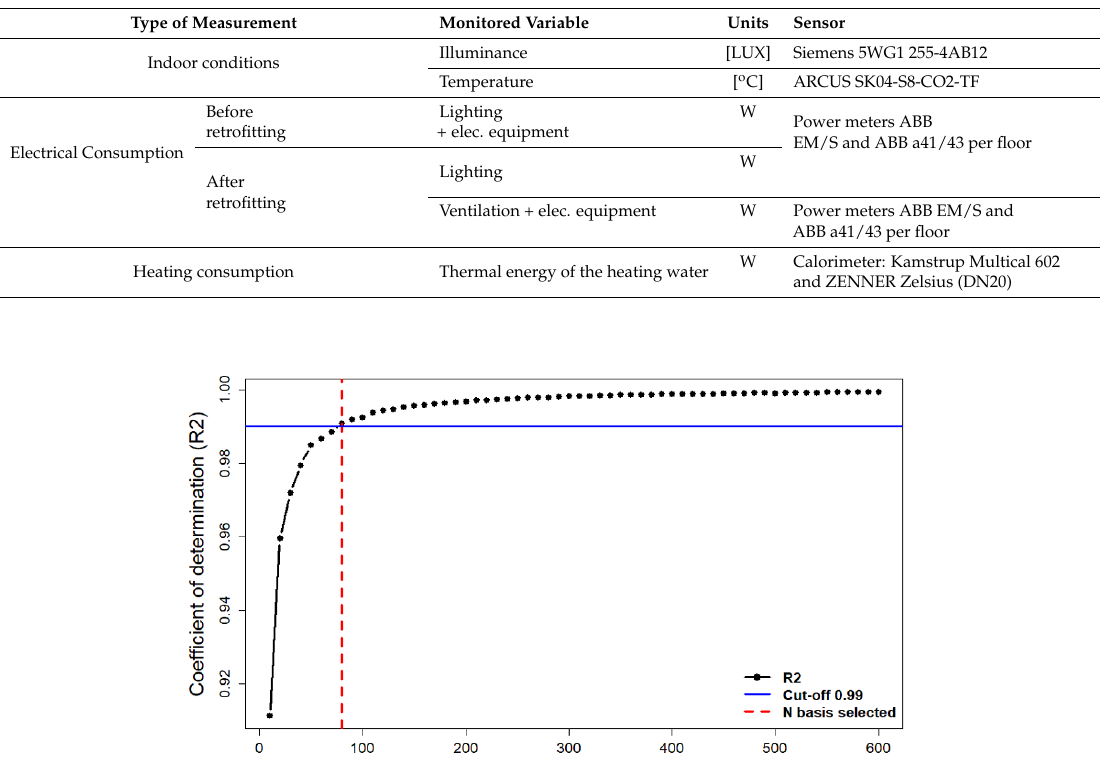
Table 1. Monitored variables in the building to assess the impact of the refurbishment in the energy performance, illuminance and comfort of the building.